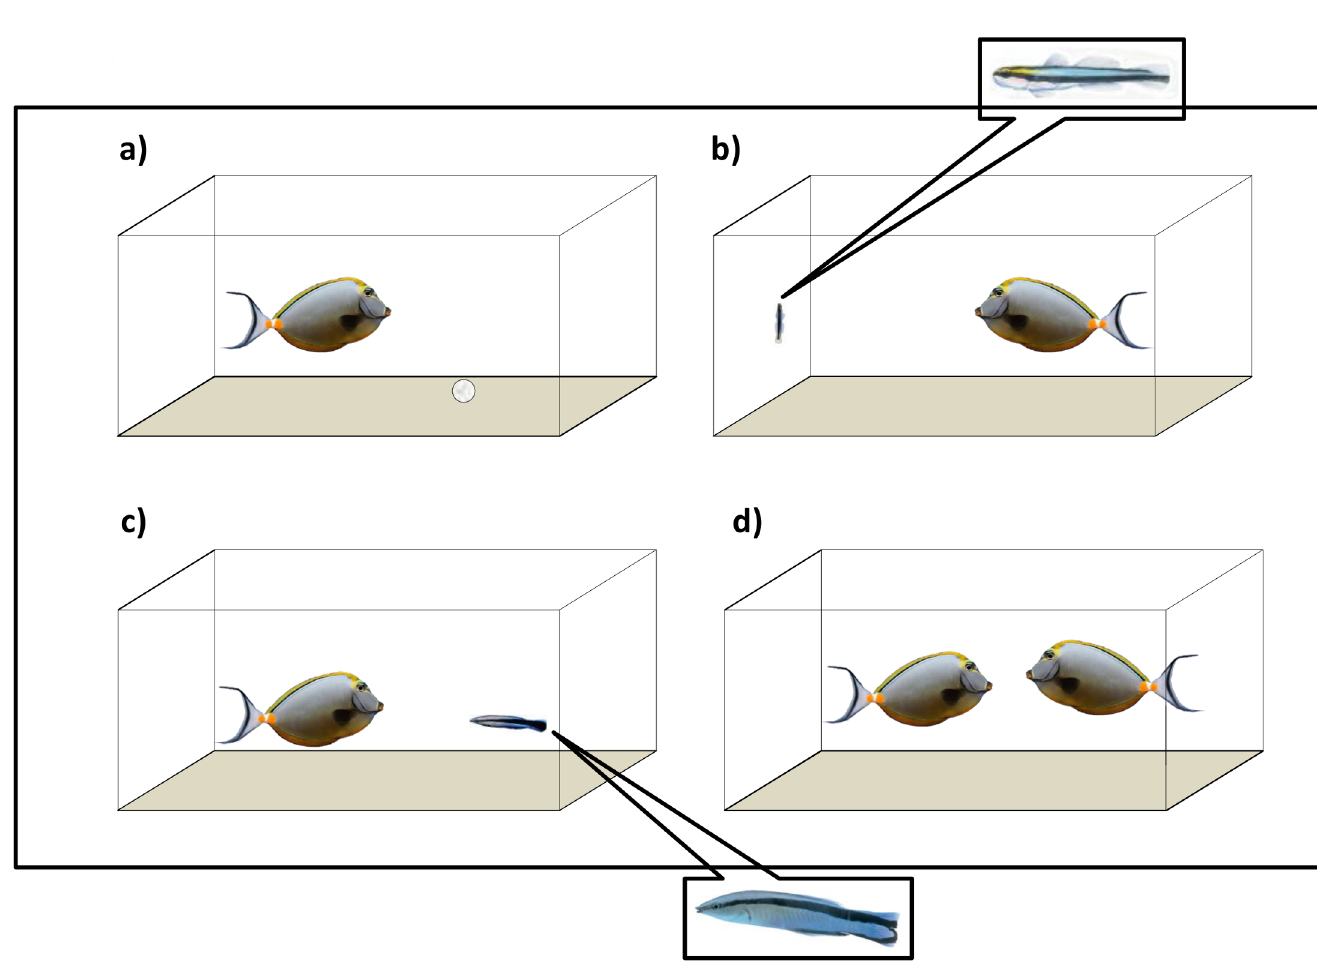
Fig 1. Experimental setup. (A) Individualclient fish (Indo-Pacific Naso elegans )is introduced to a novel object (a white ball), (B) Individual client fish is introducedto an allopatriccleaner species (the Caribbean cleaninggoby Elacatinus evelynae ), (C) Individual client fish is introducedto a sympatric cleaner species (the Indo-Pacificcleaner wrasse Labroidesdimidiatus ) and (D) Individual client fish is introduced to a conspecific. Images of fish are not in real scale, particularlythose of the cleaner fish L . dimidiatus and E . evelynae when compared with client N . elegans